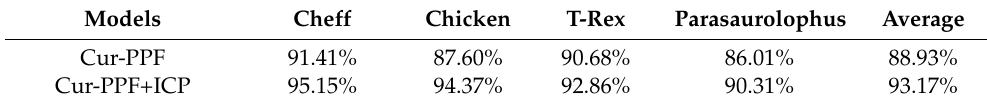
Table 5. The matching rate of Cur-PPF and Cur-PPF+ICP algorithms on Laser Scanner.